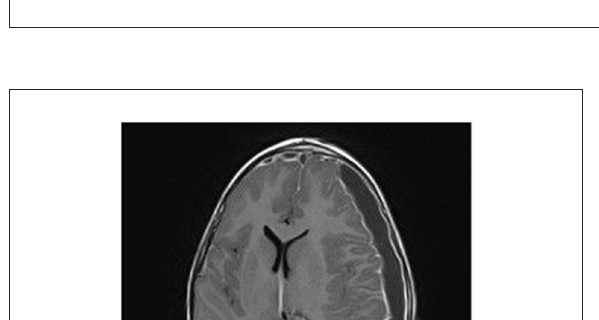
FIGURE1 Biological course.